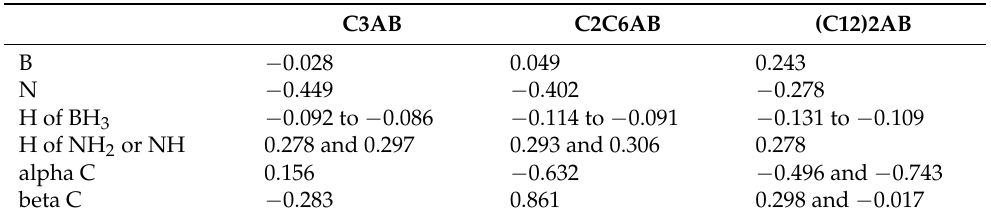
Table 1. Mulliken charges of the elements B, N, H of BH 3 , H of NH 2 or NH 2 , alpha C and beta C, for the molecules C3AB, C2C6AB and